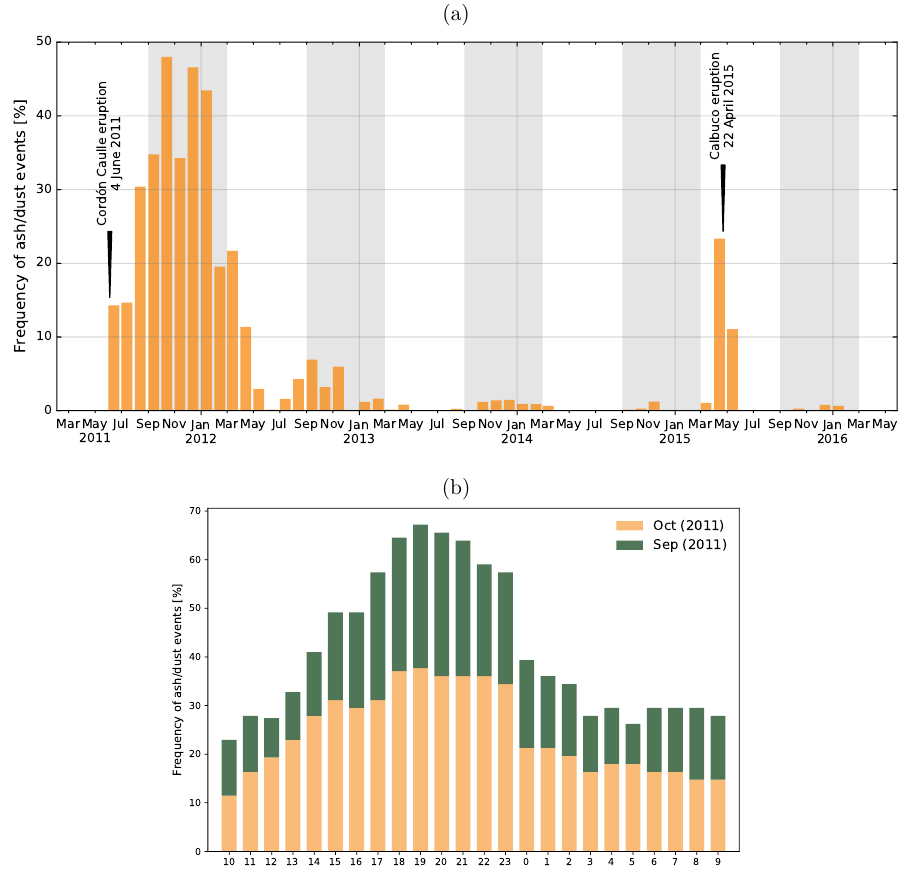
Figure 8. Frequency of events of ash/dust in suspension, that is, f E as defined in Equation (10), estimated from hourly METAR reports issued by the Bariloche weather station. ( a ) Monthly frequency shows a clear seasonal pattern with maximum activity in austral spring (Sep-Oct-Nov) and summer (Dec-Jan-Feb), indicated by shaded areas. Consolidation and depletion of volcanic deposits results in a year-to-year decrease of frequency, f E . New ash resuspension events following the Calbuco eruption are obvious from the new peak in 2015. The onset of Cordón Caulle (4 June 2011) and Calbuco (22 April 2015) eruptions are indicated by arrows. ( b ) Hourly frequency distribution shows a clear diurnal pattern, with most of the events occurring during the afternoon, with the peak of frequency at 19:00 UTC (16:00